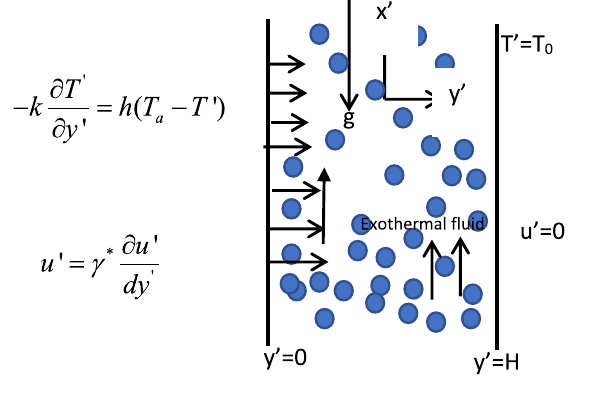
Figure 1. Physical coordinate of the flow